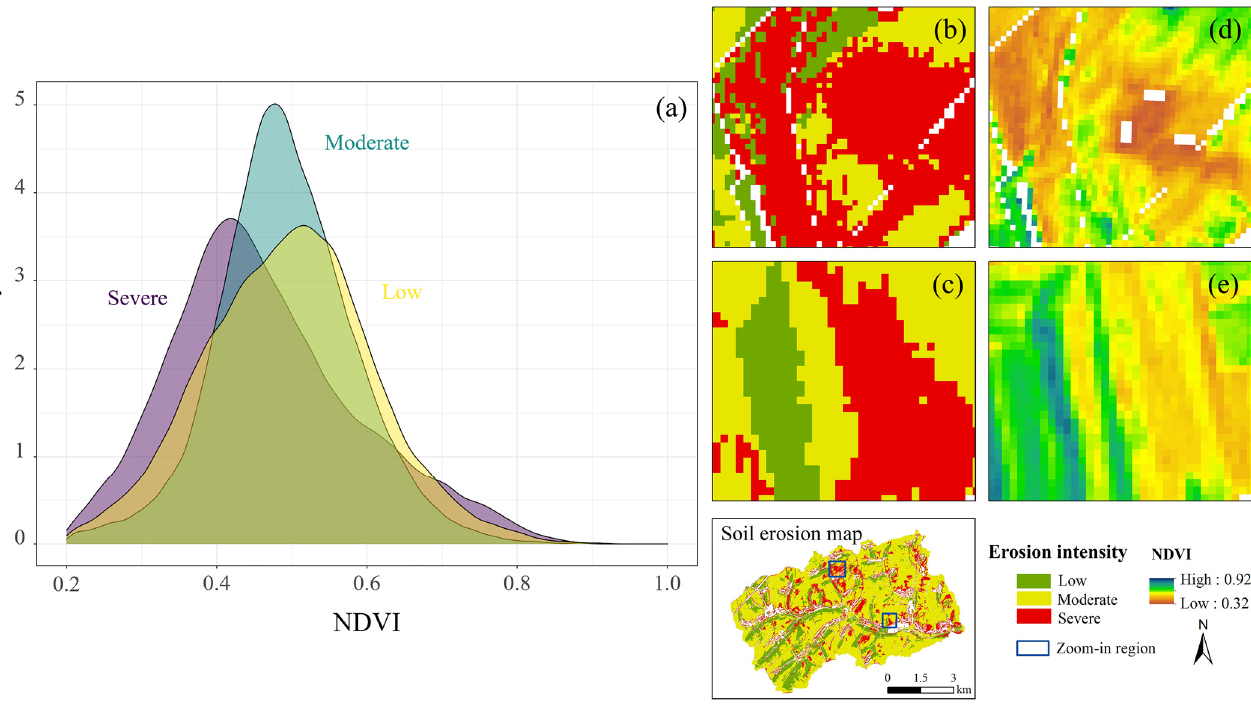
Figure 10. ( a ) Density plots of NDVI in June 2021 for the three erosion intensity classes within the cropland extent; ( b , c ) zoomed-in areas with detailed soil erosion pattern and ( d , e ) the corresponding field-scale NDVI maps to depict the relation of crop variability with erosion-induced variations in soil productivity. soil